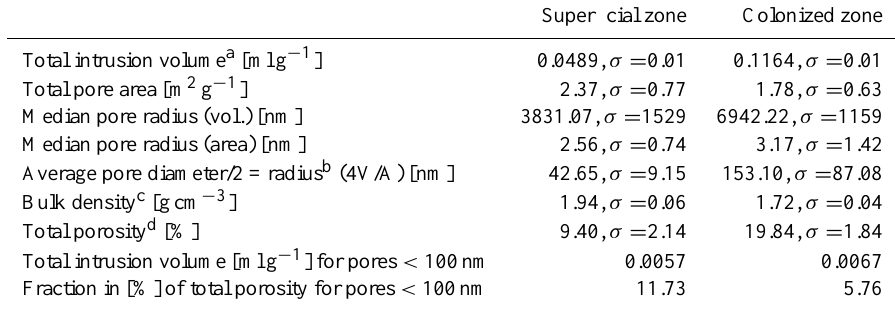
Table 1. Mercury intrusion porosimetry data.